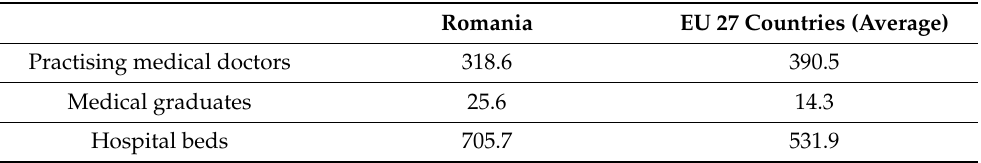
Table 3. Practicing medical doctors, medical graduates, and available hospital beds per hundred thousand inhabitants in Romania and the EU 27 average in